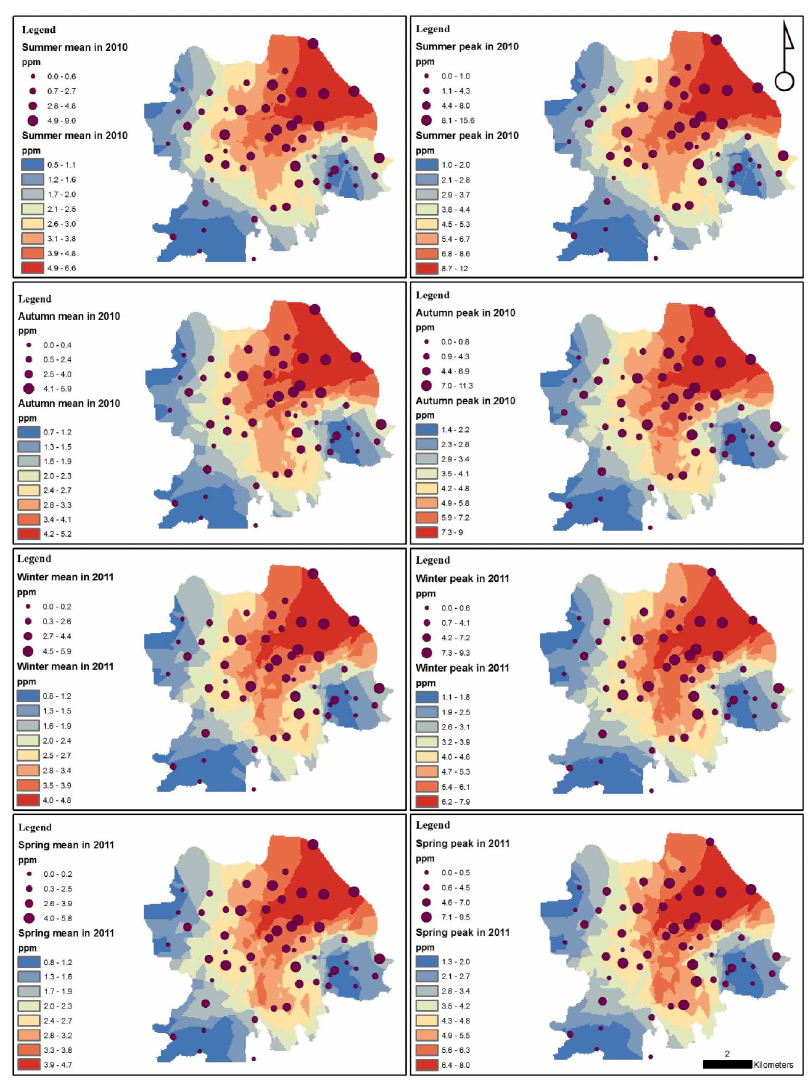
The RMSE values for the annual mean and annual peak were respectively 0.4 and 0.7 ppm, which indicate small errors in the predicted surfaces.